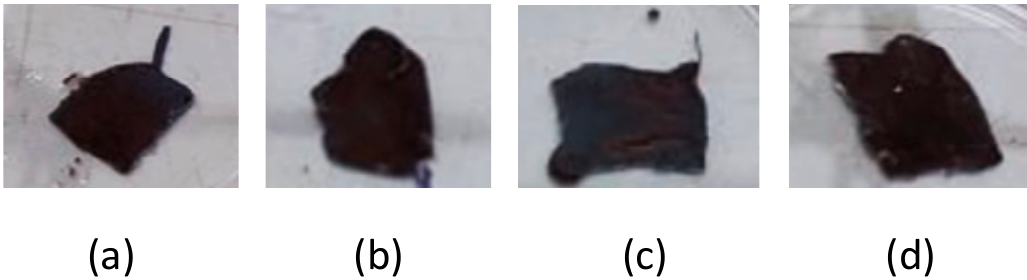
Figure 7. Photographs of magnetically modified electrospun CA fibrous mats. The modification step was realized via drop casting of a specific amount of MIONP-OAOA aqueous solutions onto the fibrous mats. The four samples ( a – d ) were prepared by drop casting of magnetic aqueous solutions of variable concentrations as follows: Sample a—drop casting of the as-synthesized mother solution; sample b—drop casting of 2× dilution of the mother solution; sample c—drop casting of 5× dilution of the mother solution; sample d—drop casting of 10× dilution of the mother solution.